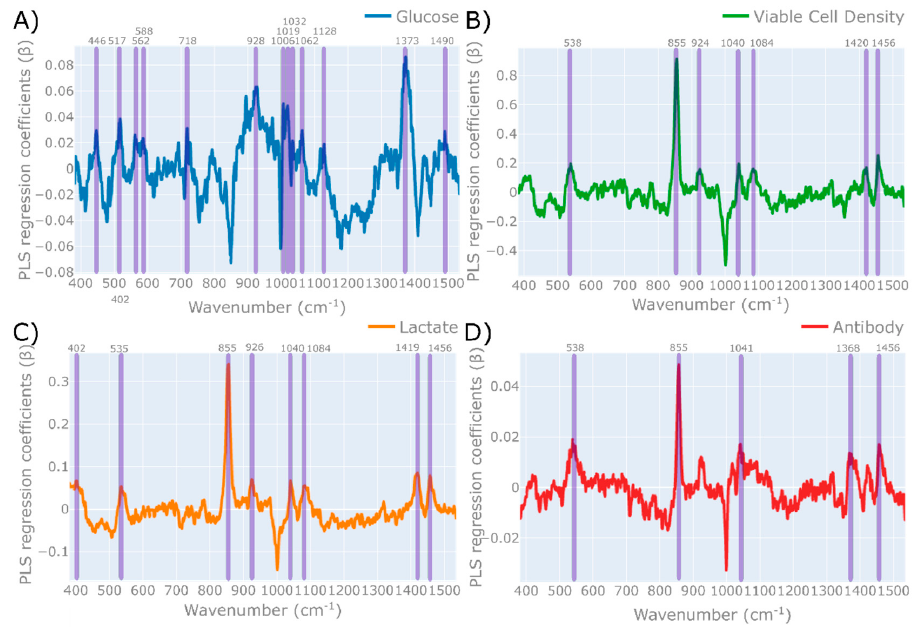
Figure 5. PLS regression coe ffi cients ( β ) of each PLS model generated for ( A ) glucose, ( B ) viable cell density, ( C ) lactate, and ( D ) antibodies, with the wavenumbers corresponding to the Raman molecular signature of each variable highlighted by the shaded areas. The cut-off points for these PLS regression coefficients are glucose: β > 0.02; VCD: β > 0.2; lactate: β > 0.05; and antibody: β > 0.015. The spectral data utilised in each PLS model were baseline-corrected spectra using a 1st order polynomial function, followed by the application of an SNV scattering scatter algorithm and a Savitzky–Golay smoothing filter.